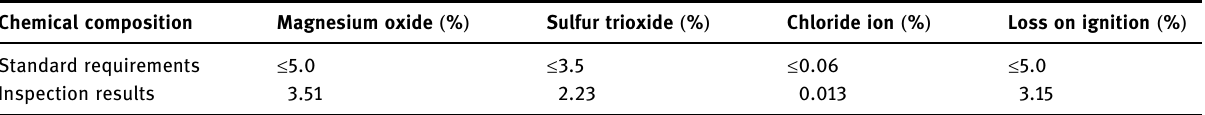
Table 3: Chemical composition of